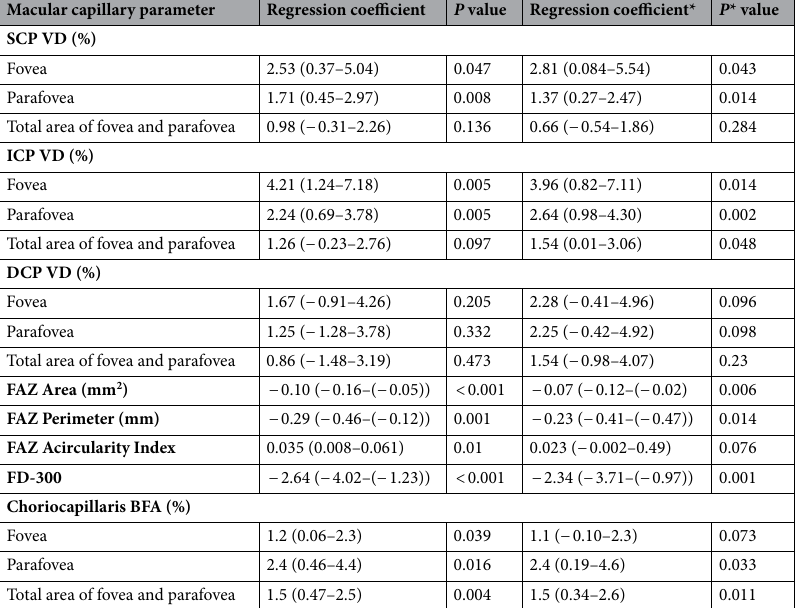
black as compared to white subjects (mean VD 47.1 ± 2.73% in black vs 47.8 ± 2.30% in white subjects, p = 0.284), however it did not reach statistical significance. In the ICP, black subjects showed significantly lower VD in the fovea (mean VD 26.5 ± 8.61 in black vs 30.4 ± 7.55% in white subjects, p = 0.014), the parafovea (mean VD 45.1 ± 2.81% in black vs 47.2 ± 3.11% in white subjects, p = 0.002), and the total area encompassing the fovea and parafovea (mean VD 43.4 ± 2.70% in black vs 44.9 ± 2.53% in white subjects, p = 0.048). Within the DCP, there was a trend toward lower VD among black subjects in the fovea (mean VD 20.3 ± 7.03% in black vs 21.7 ± 5.72% in white subjects, p = 0.096), the parafovea (mean VD 40.0 ± 6.18% in black vs 40.7 ± 5.14% in white subjects, p = 0.098), and the total area encompassing the fovea and parafovea (mean VD 37.5 ± 5.26% in black vs 38.1 ± 5.26% in white subjects, p = 0.23) however it did not reach statistical significance. Foveal avascular zone parameters are reported in Table 3. Black subjects had significantly larger FAZ area (mean FAZ area 0.332 ± 0.120 mm 2 in black vs 0.221 ± 0.705 mm 2 in white subjects, p = 0.006) and larger FAZ perimeter than white subjects (mean FAZ perimeter 2.22 ± 0.38 mm in black vs 1.91 ± 0.30 mm in white sub- jects, p = 0.014). There was no significant difference in FAZ AI between black and white subjects (mean FAZ AI 1.11 ± 0.036 in black vs 1.15 ± 0.080 in white subjects, p = 0.076). Vessel density in FD-300 was significantly higher in black as compared to white subjects (FD 53.3 ± 2.84 in black vs 50.3 ± 3.20 in white subjects, p = 0.001).